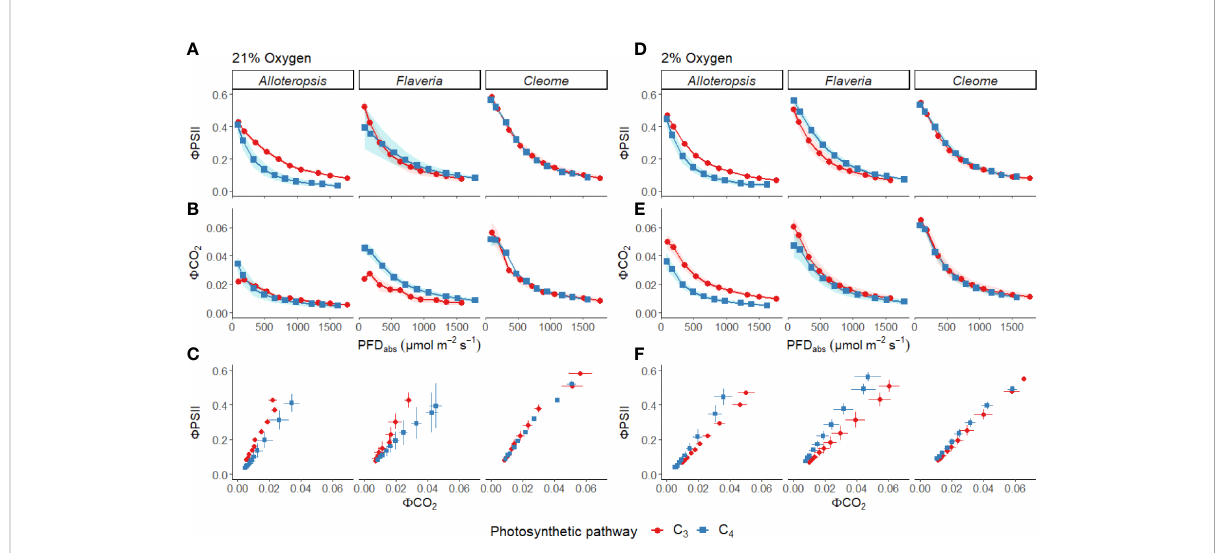
FIGURE 3 Measurements of gas exchange and chlorophyll fl uorescence traits during light response curves for phylogenetically linked C 3 and C 4 Alloteropsis , Flaveria and Cleome species under 21% and 2% O F PSII, A , D ), and quantum yield of CO 2 . Plots show quantum yield of PSII ( 2 assimilation ( F CO 2 , B, E ) as a function of absorbed light intensity. Ribbons represent standard error of the mean (n=5). Plots (C, F) display the relationship between F PSII and F CO 2 . Error bars represent standard error of the mean for both